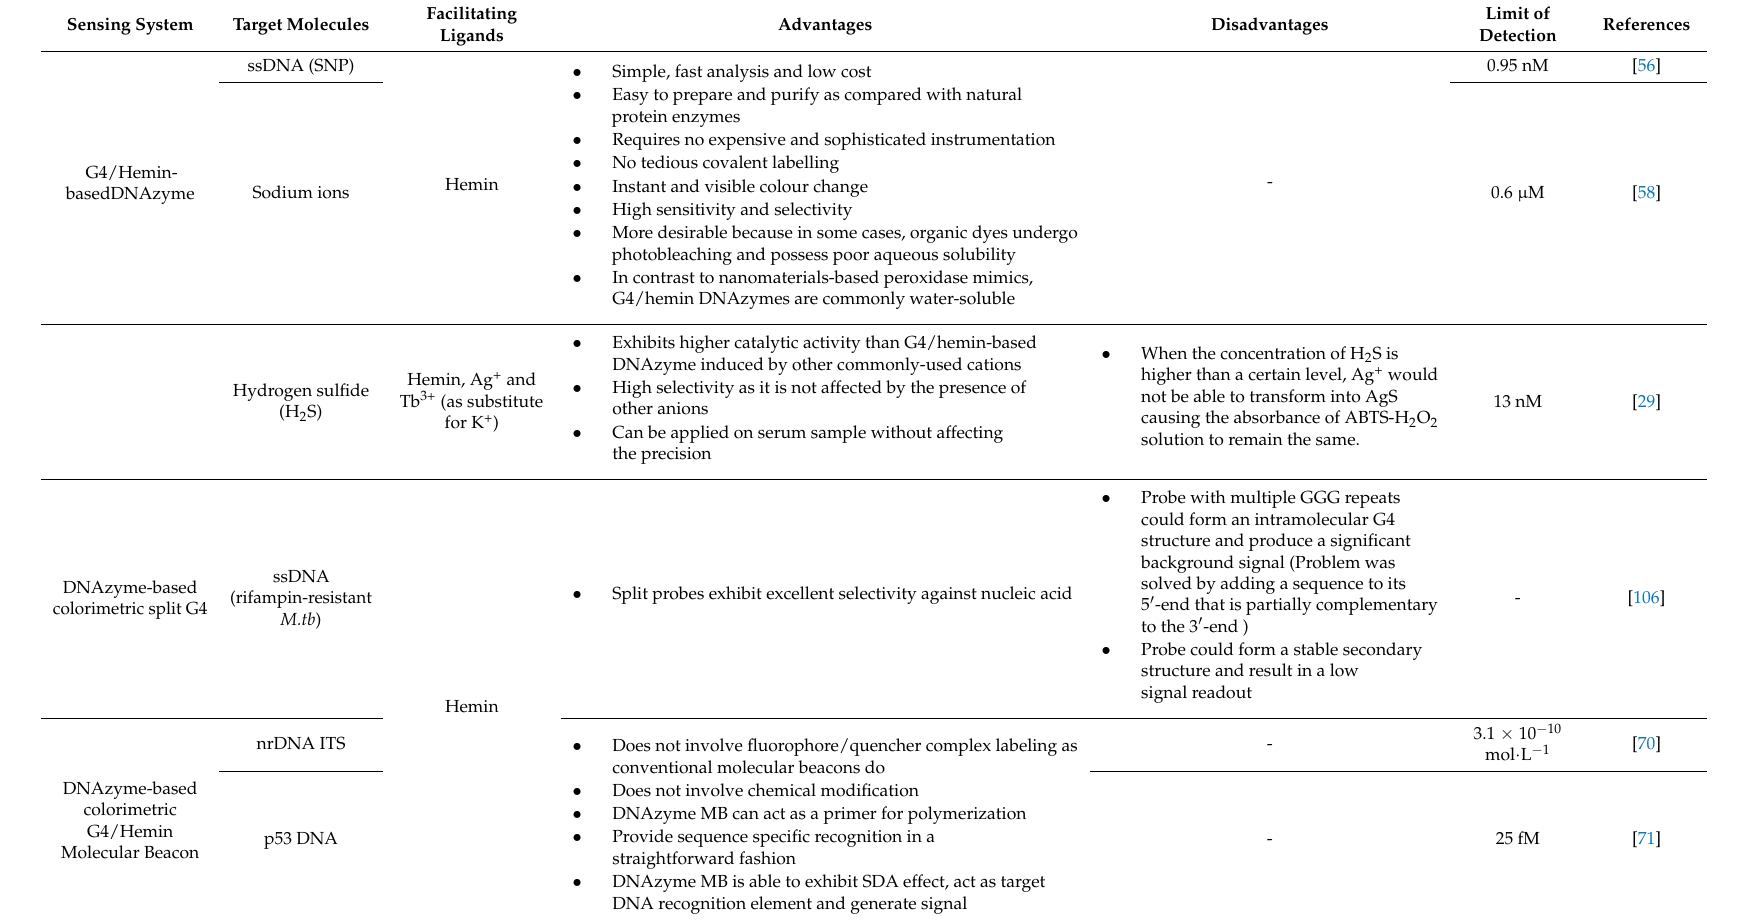
Table 2. Characteristics of different G4-based detection